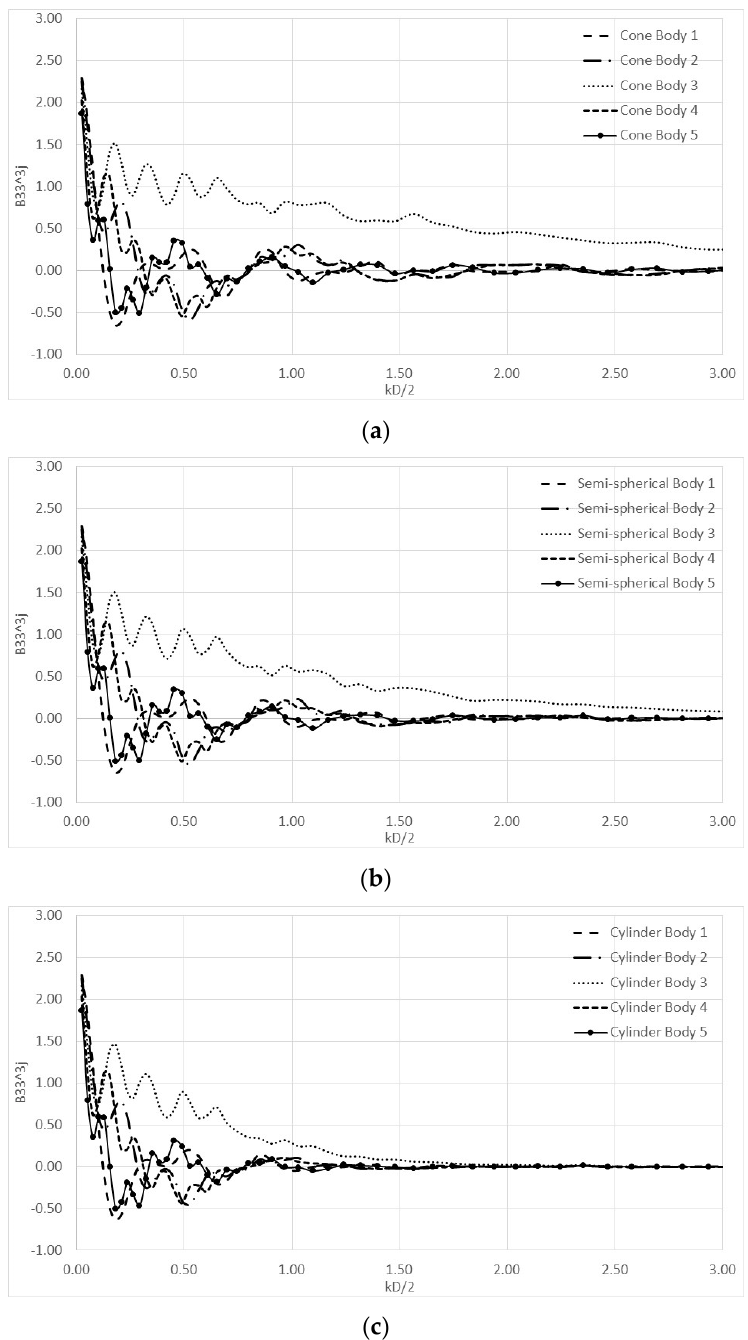
Figure 20. Dimensionless damping coefficient of the 3rd floater at the heave direction due to the forced motion at heave of the j- th floater ( j = 1, 2, …, 5) against kD/2, for the three different examined types of floaters: ( a ) conical floater; ( b ) semi-spherical floater; ( c ) cylindrical floater in the perpendicular arrangement, C 3 .